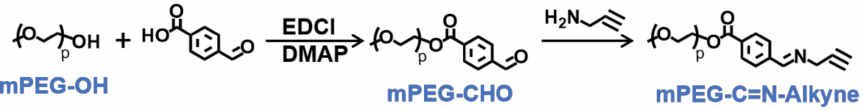
Figure 4. Synthetic route of mPEG-C=N-Alkyne.